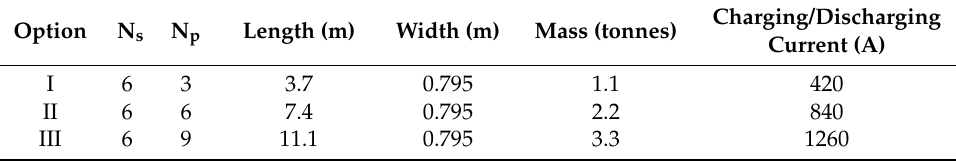
Table 2. ESD parameters per traction carriage.